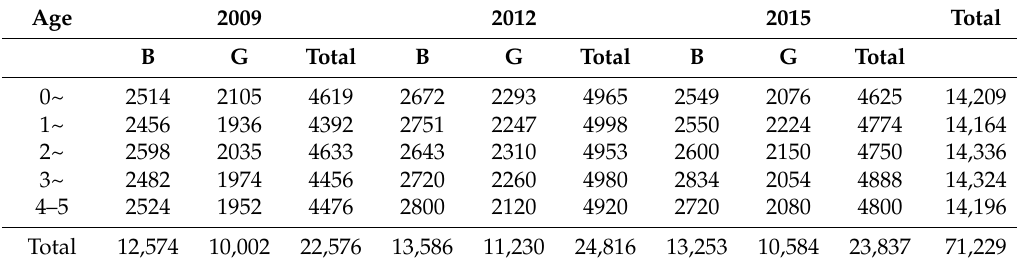
Table 1. Sample size of each age and sex group by year of evaluation (B = boys; G =